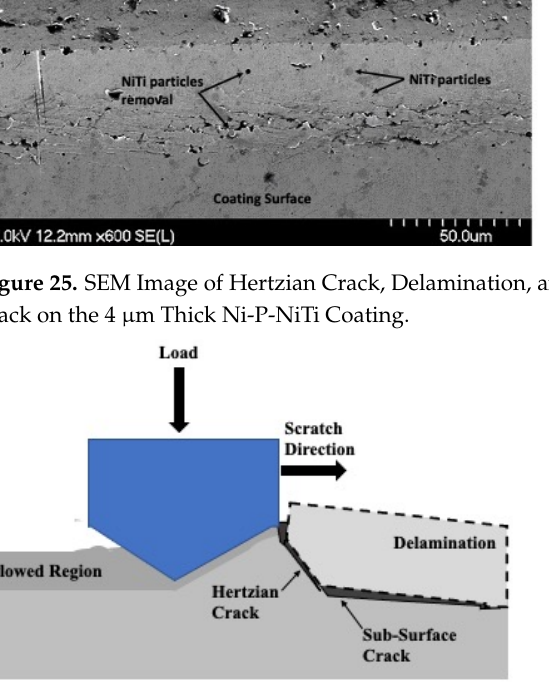
Figure 26. Illustration of Wear Debris from Intersecting Hertzian Crack and Subsurface Crack.